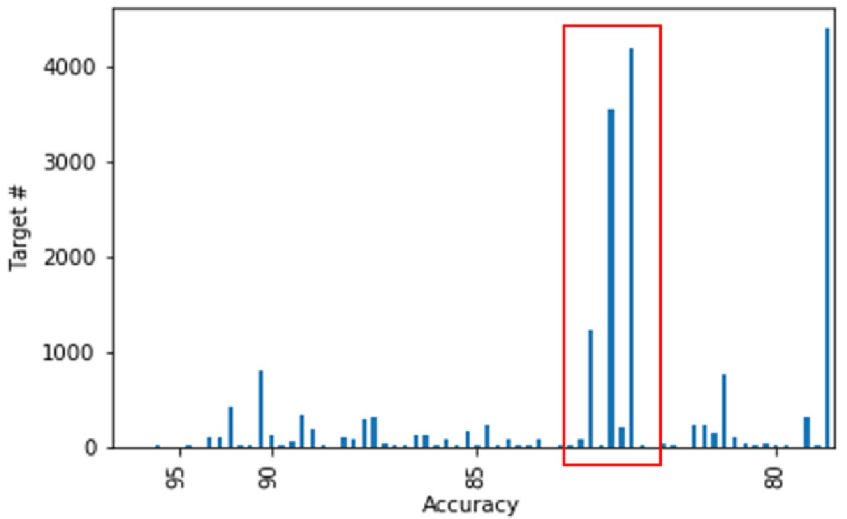
Fig 8. Number of targets in the model versus top-one